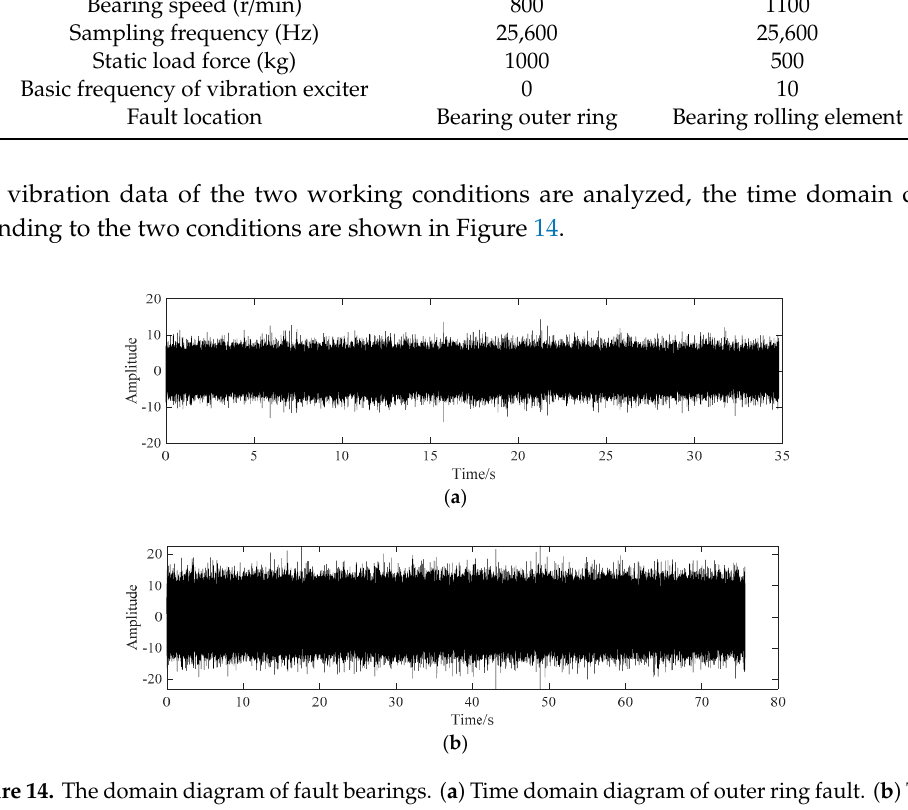
Figure 15. Sectional time domain diagram of outer ring fault.